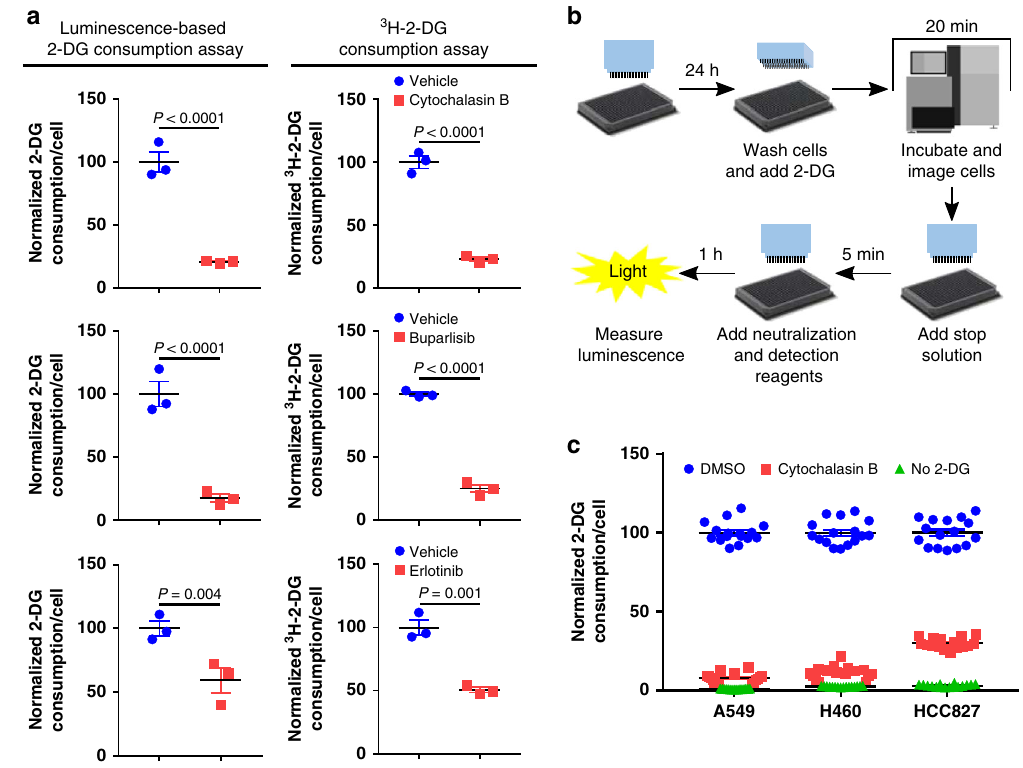
Fig. 1 A high-throughput assay for measuring glucose consumption. a Glucose consumption in H460 (top and middle) and HCC827 (bottom) cells treated with Cytochalasin B (10 μ M), Buparlisib (1 μ M), Erlotinib (200 nM), or vehicle, measured by a luminescence-based 2-DG or a 3 H-2-DG consumption assay. n = 3. P values determined by a two-way ANOVA test. b Schematic work fl ow of a luminescence-based high-throughput assay for measuring glucose consumption. c Glucose consumption, measured by a high-throughput assay, in A549, H460, and HCC827 cells treated with DMSO, Cytochalasin B (10 μ M), or without 2-DG. n = 16. Data are plotted as mean ±